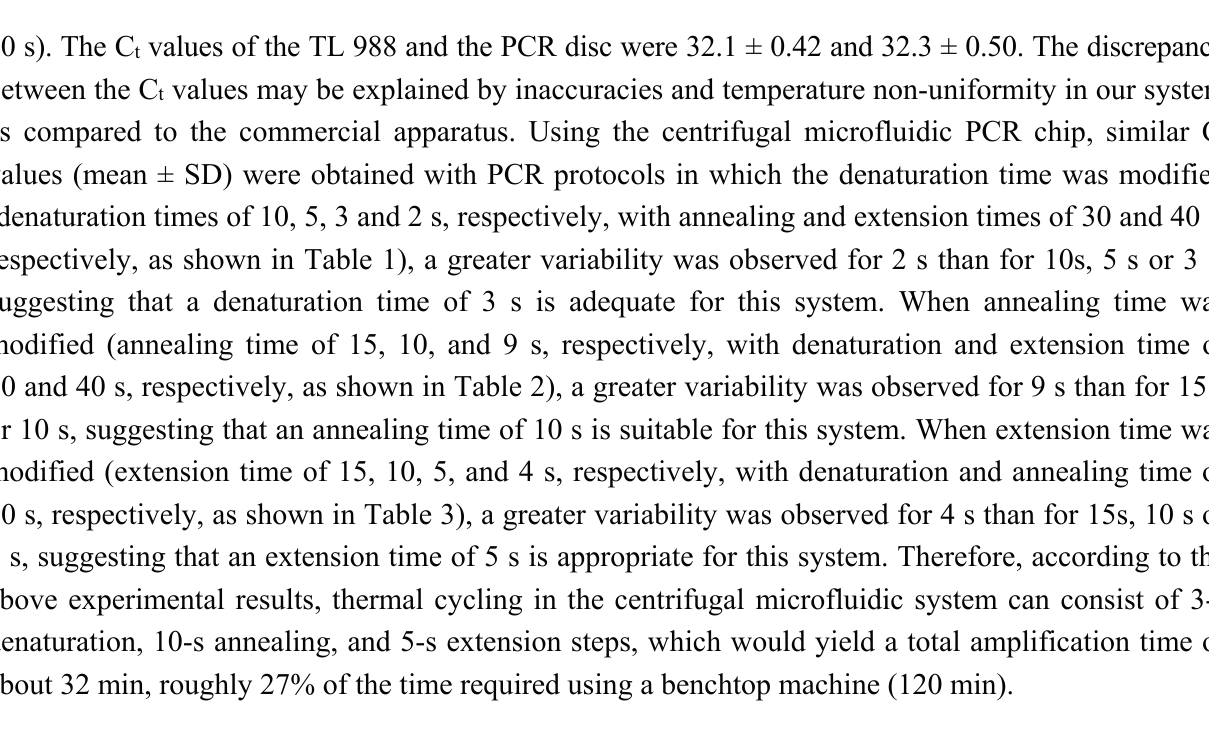
Table 1. C t values with denaturation time of 10, 5, 3 and 2 s, respectively, annealing and extension time of 30 and 40 s, respectively.